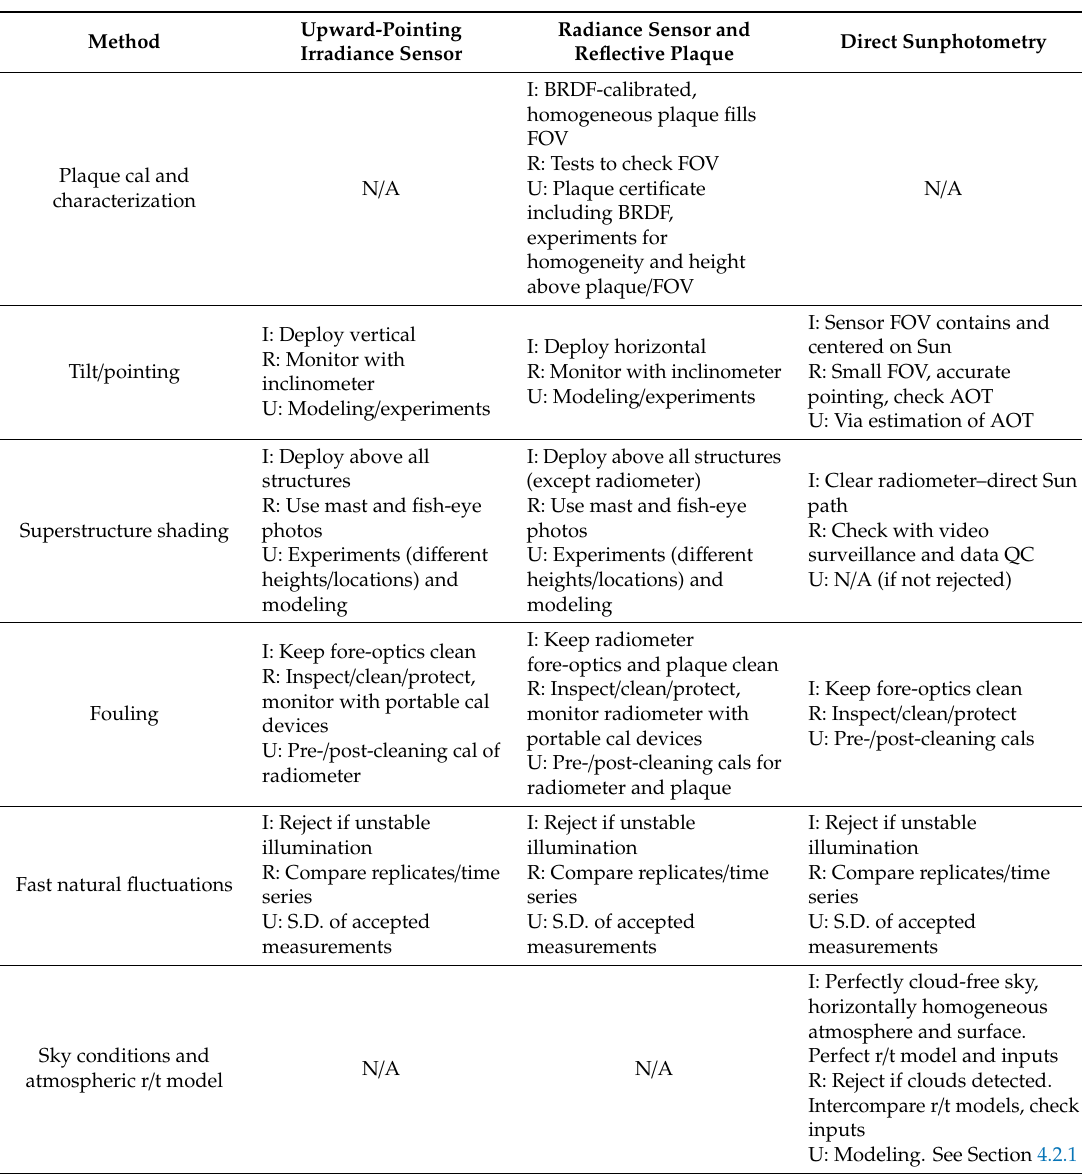
Table 2. Summary of the three measurement methods, including components that must be considered for the uncertainty estimation. BRDF: bidirectional reflectance distribution functions; I = Ideal conditions; R = Recommendations; U = Uncertainty estimation; Cal = calibration; FOV = field of view; AOT = aerosol optical thickness; r / t = radiative transfer; S.D. = standard deviation; N / A = Not Applicable. See text for more details on each